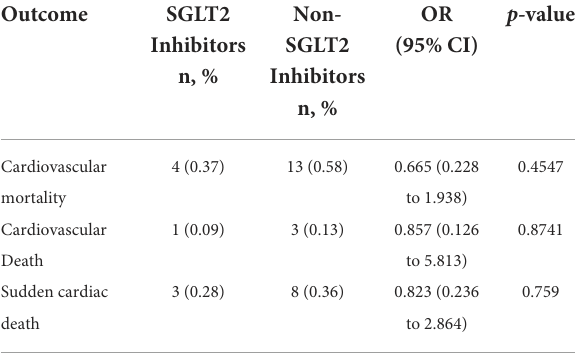
TABLE 4 Mortality outcomes of study population.